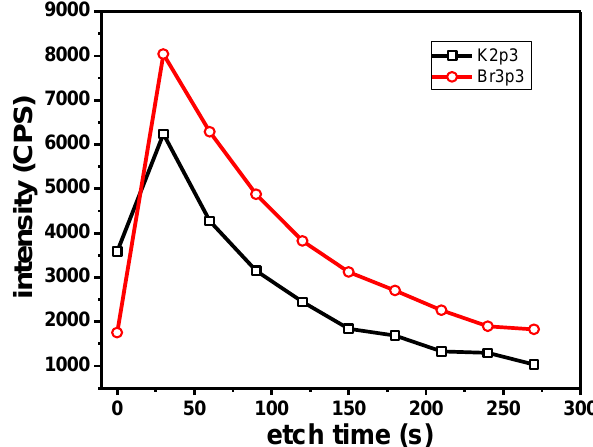
Figure 10. Variation of K (black) and Br (red) peak intensity with etching time.